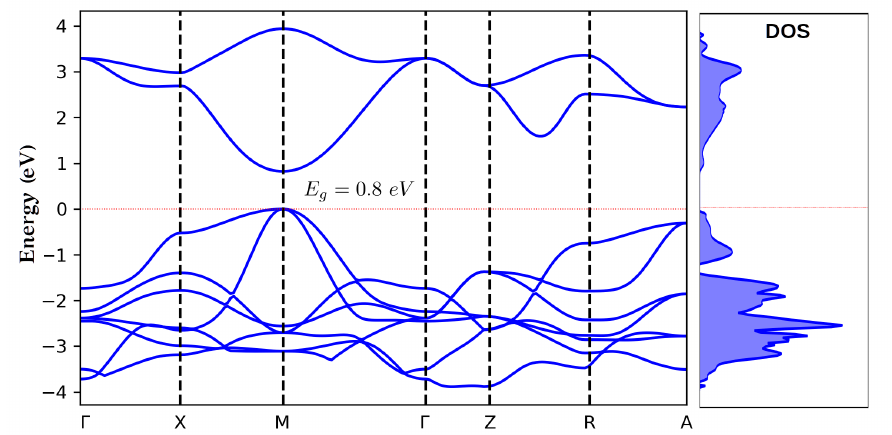
Figure 5. Band structure and density of states diagrams of PdO, as obtained by DFT/B3LYP/BOP- TZVP calculations.